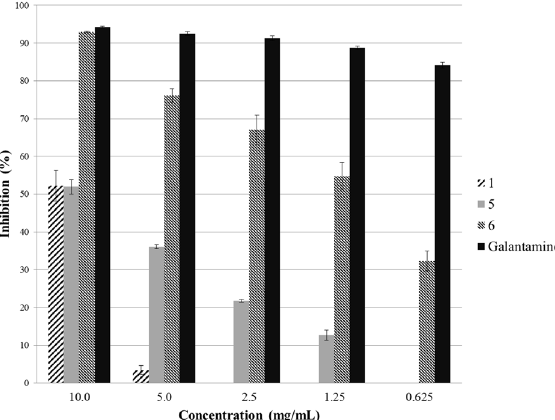
Figure 2 - AChE Inhibitory Activity of 1 , 5 , 6 and galantamine at the concentrations of 10.0, 5.0, 2.5, 1.25 and 0.625 Percentage of AChE inhibition of diterpenes 1-6 (10 mg/mL). Compounds AChE Inhibitory (%) Standard Deviation Galantamine 94.21 0.20